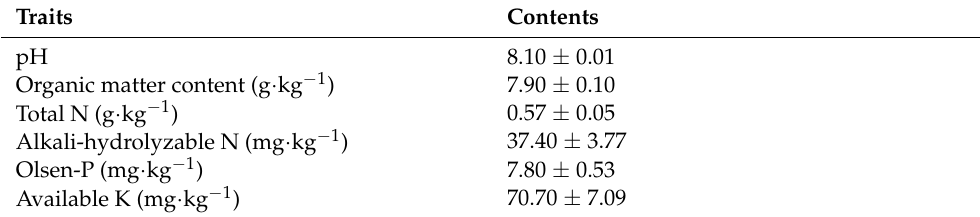
Table 1. The soil chemical properties.